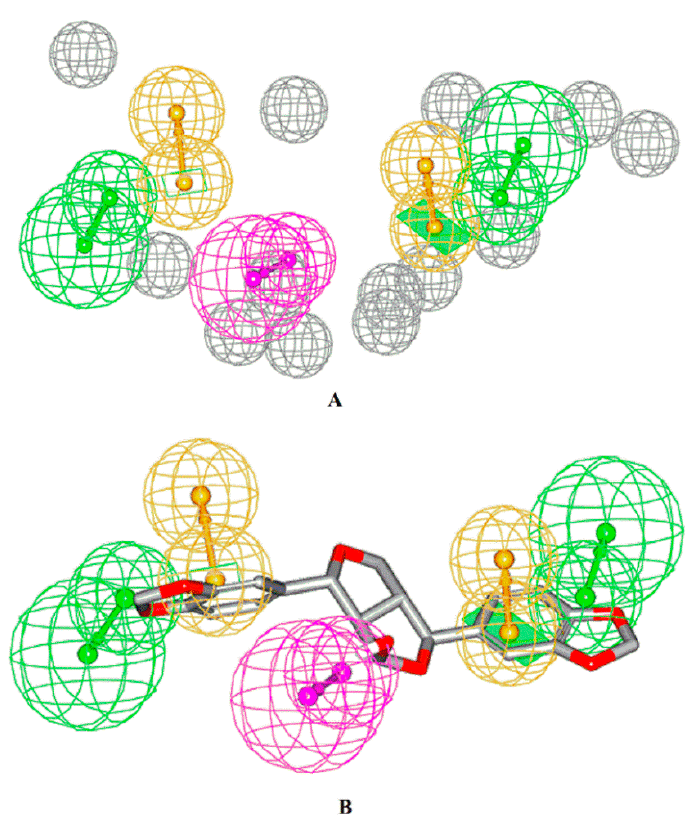
Figure 4. ( A ) The highest-ranked pharmacophore model generated for compounds 35 – 38 . Hydrogen bond acceptor (HBAs) are represented as green-vectored spheres, hydrogen bond donor (HBD) is represented as a purple-vectored sphere, Ring Arom features are represented as an orange-vectored sphere, and the exclusion volumes as gray spheres. ( B ) Structure of compound 35 and how it aligns the pharmacophore map. Exclusion spheres were hidden for clarity.